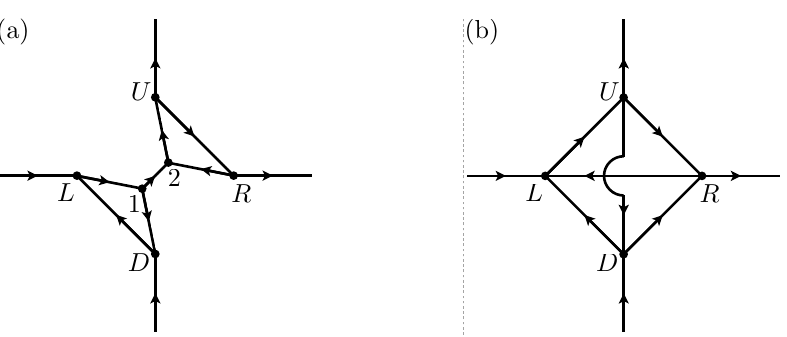
Figure 3: The six-site (a) and the four-site (b) cluster that may be used to expand the lattice for the dimer